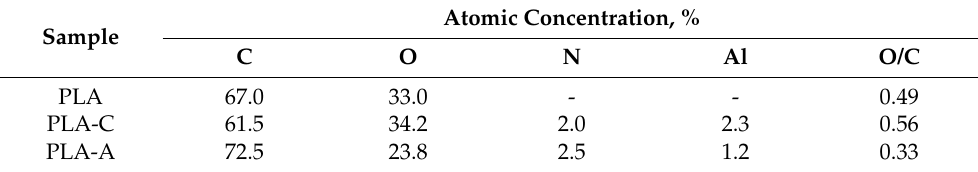
Table 1. Surface chemical structure of the initial and plasma-treated PLA